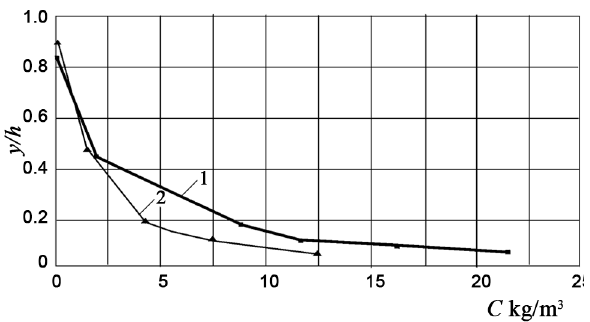
Fig. 6. Vertical sediment distribution measured during the runs: 1 – BF-SO215 and 2 – BF-SO2